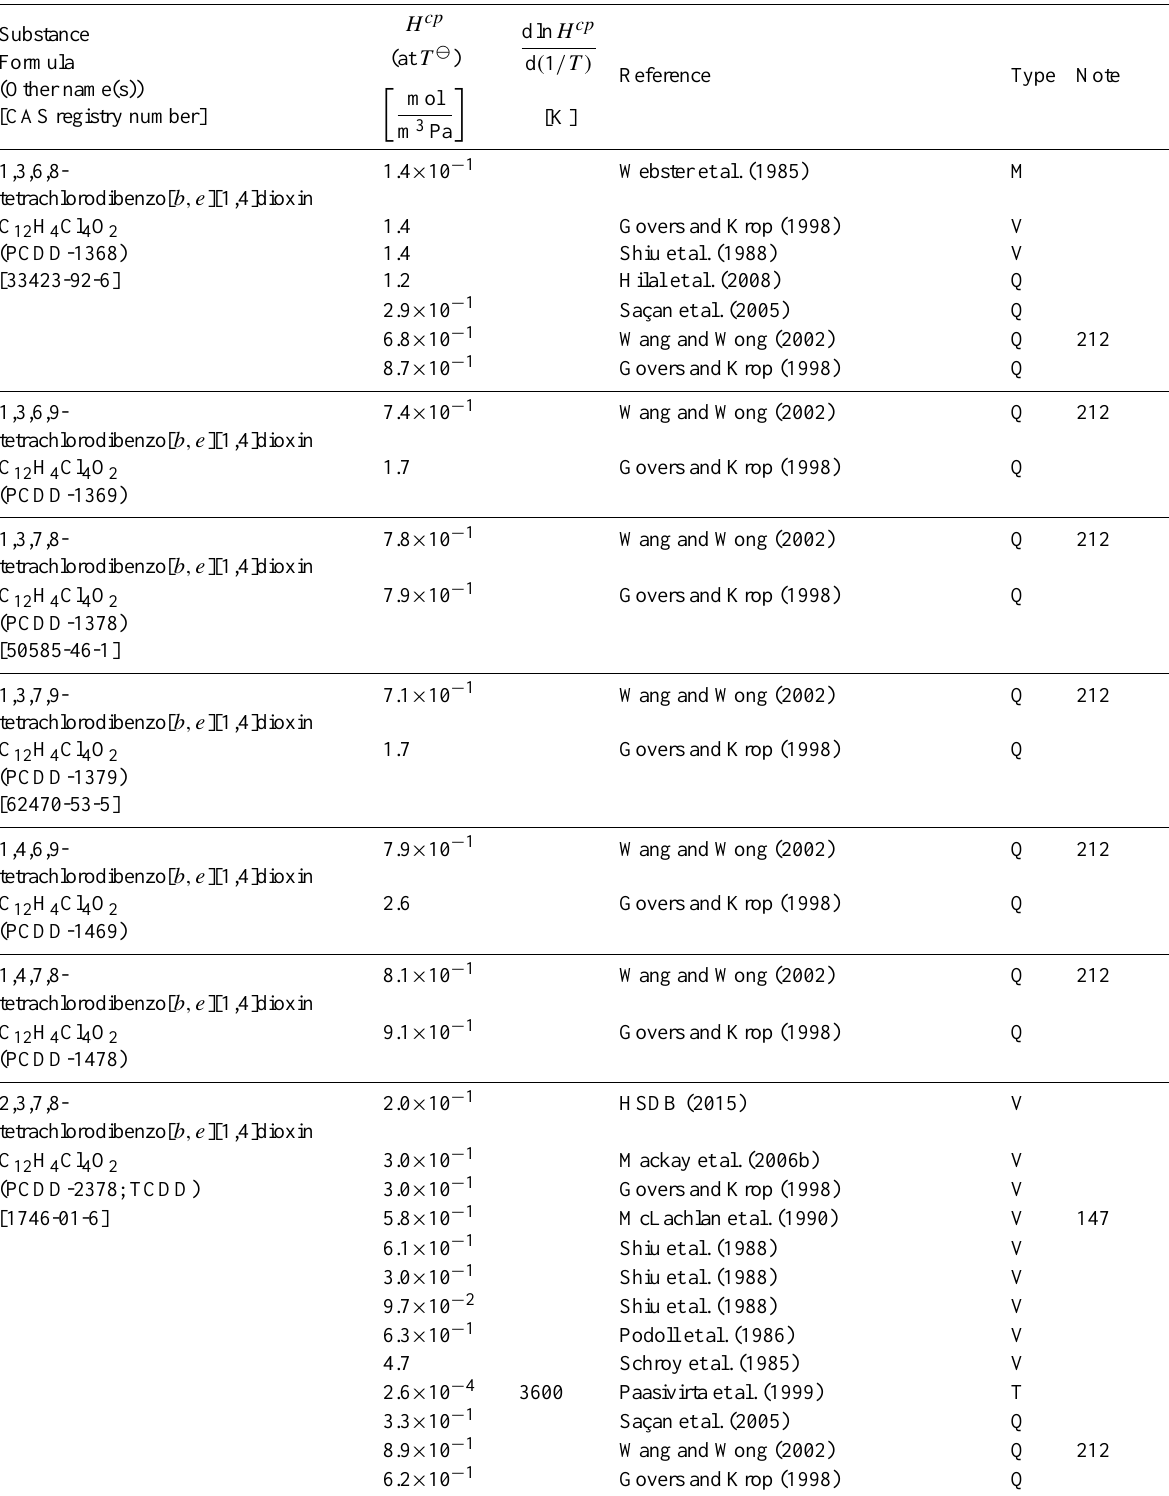
Table 6: Henry’s law constants for water as solvent